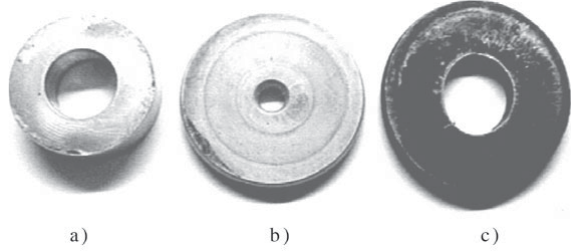
Figura 1. Anéis deformados no ensaio de compressão.